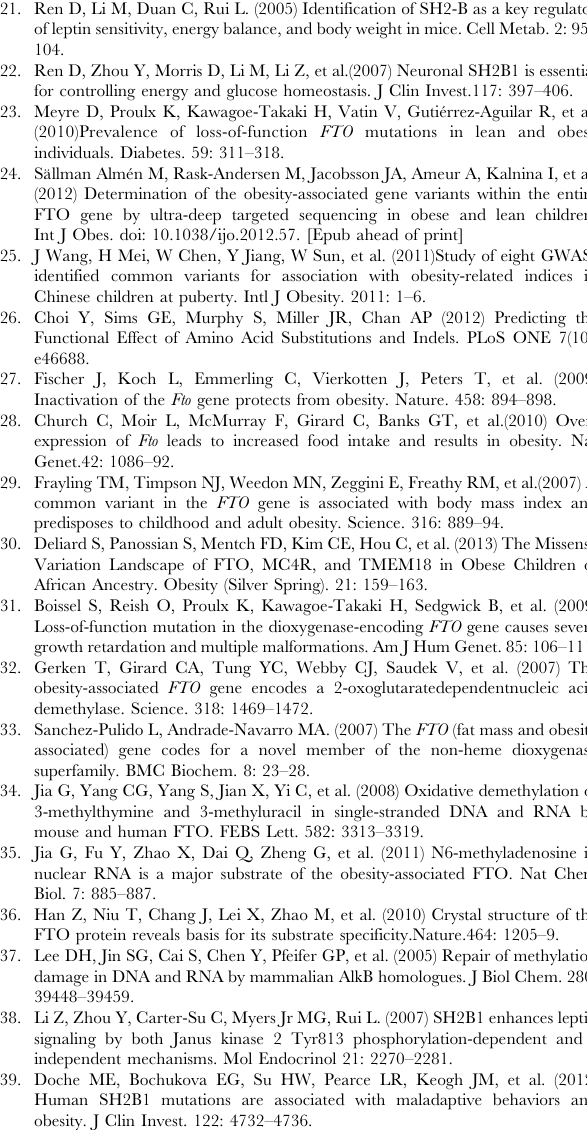
Table S1 PCR primers for amplification of FTO coding regions. (DOCX) Table S2 PCR primers for amplification of SH2B1 coding